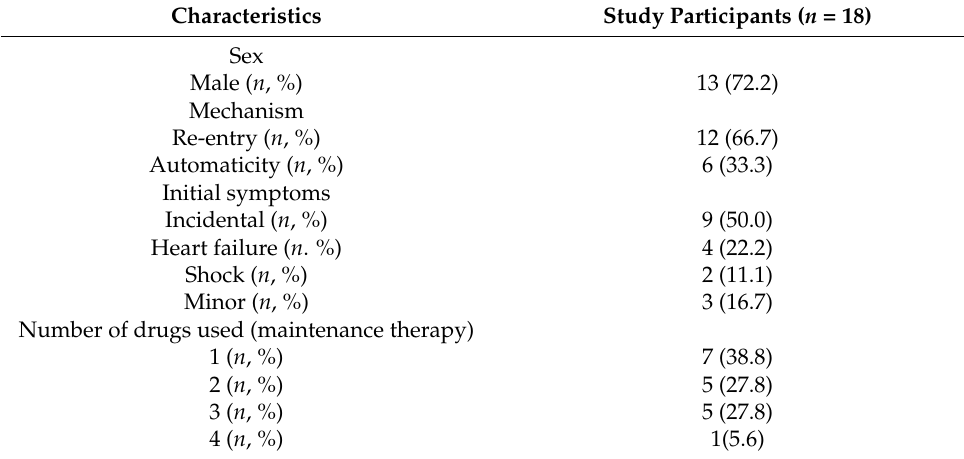
Table 2. Patient characteristics (nominal